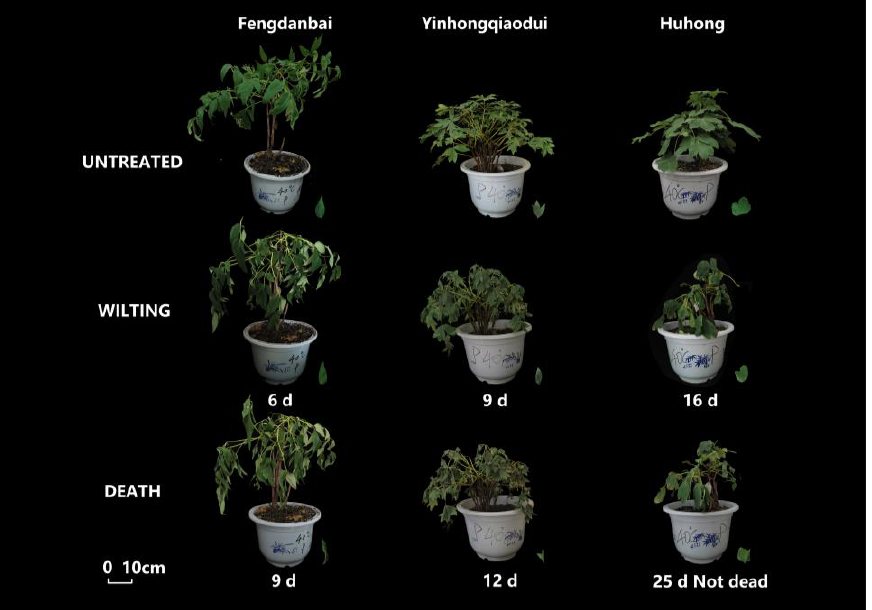
Figure 1. Morphological changes in ‘Fengdanbai’ ‘Yinhongqiaodui’ and ‘Huhong’ cultivars of peony under high-temperature stress. The experimental group was treated with a high temperature of 40 ◦ C and the rest remained the same as the control group. Table 2. The changes in the leaf thickness of Fengdanbai’ ‘Yinhongqiaodui’ and ‘Huhong peony cultivars under high-temperature stress.